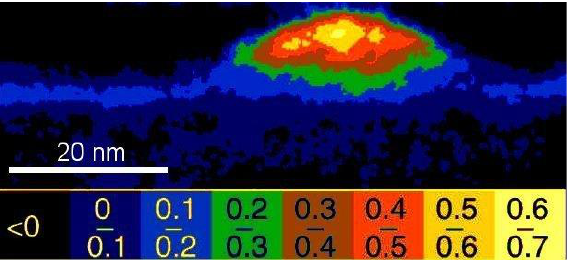
Figure 4. Indium concentration map from energy-filtered TEM (EFTEM) of an In 0.25 Ga 0.75 As quantum dot in cross-section, showing the indium depletion of the wetting layer and indium accumulation in the centre of the quantum dot by segregation. Reproduced with permission from [13] (greyscale) and [32] (colour).